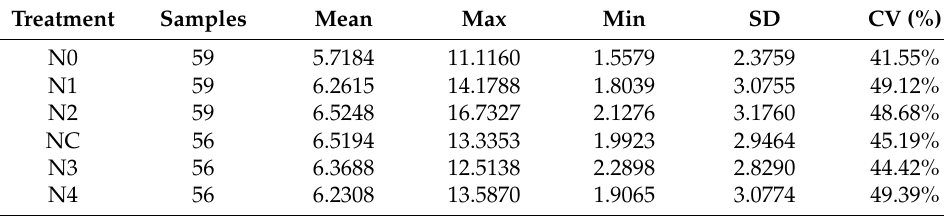
Table 4. Descriptive statistics of cotton LAI from the study